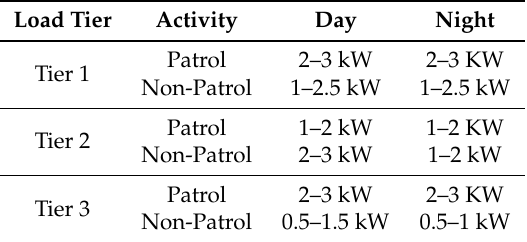
Table 2. Amount of load in each tier based on time and